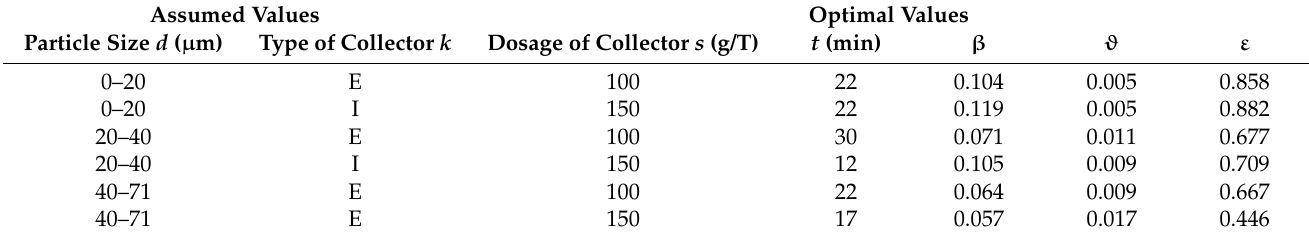
Table 7. Optimal values obtained by assumed particle size fraction and type of collector.